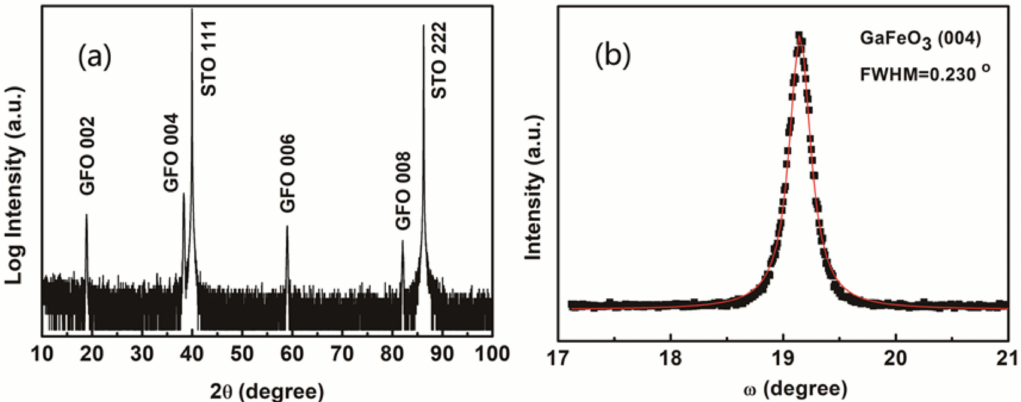
Figure 1. ( a ) Out of plane XRD 2 θ - θ pattern of the GaFeO 3 film grown on STO (111) substrate by sol-gel method and ( b ) the rocking curve of (004)